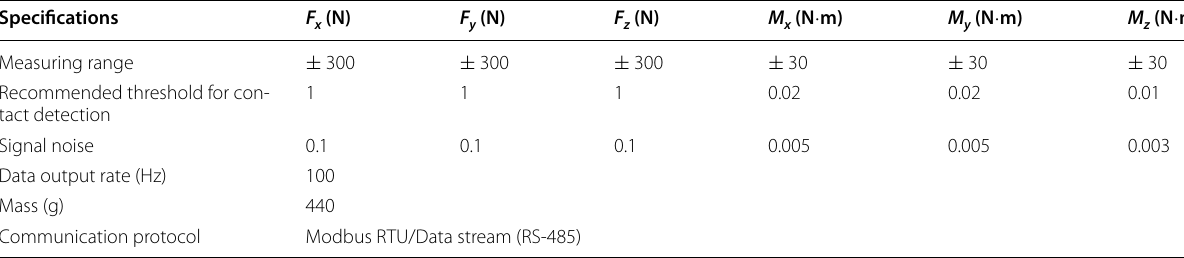
Table 1 Specifications of the FT